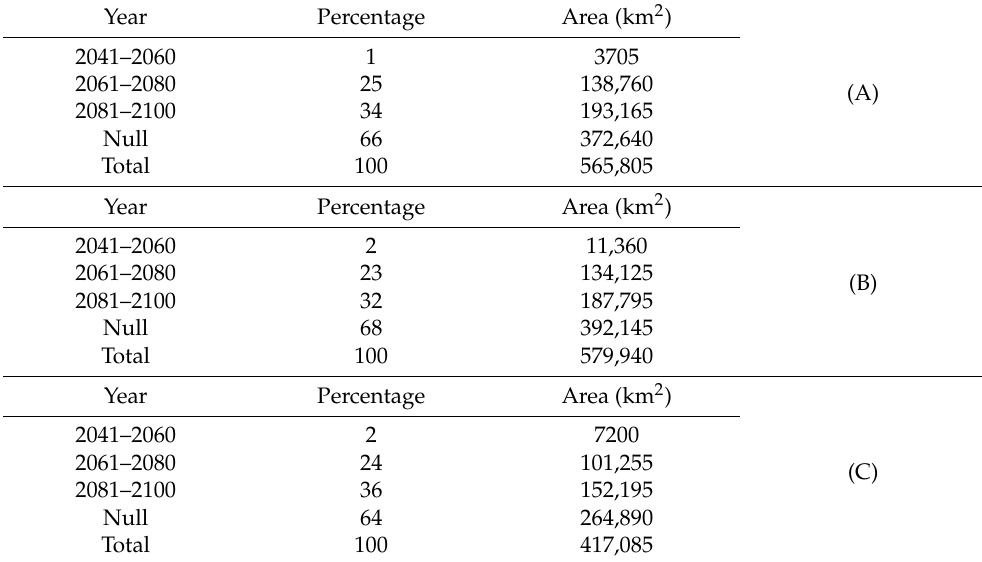
Figure 10. Prospective flooding by sea level rise based on SSP2-RCP4.5 by ( A ) 2041–2060, ( B ) 2061– 2080, and ( C ) 2081–2100. Table 6. Percentages of flood area for the Extremist scenario SSP5-RCP8.5 under the three land Table 7. Percentages and flood areas for the Conservative scenario SSP2-RCP4.5: (A) agricultural area, (B) urban area, and (C) natural resources area.